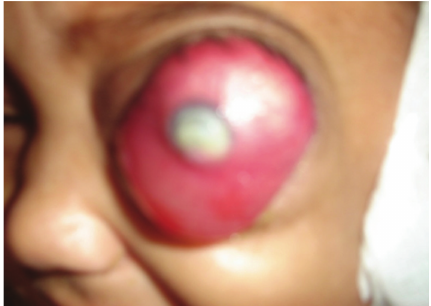
Figure 1: Photograph taken in the second hospitalisation shows exophtalmia.